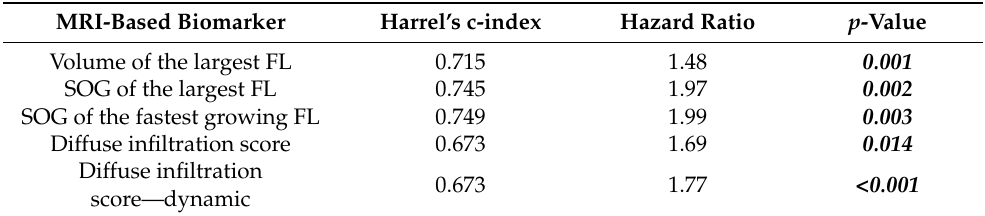
Table 1. Predictive value of size and speed of growth (SOG) of focal lesions (FL) and diffuse infiltration regarding progression to symptomatic MM (multiple myeloma). Significant findings are given in bold and italic letters.